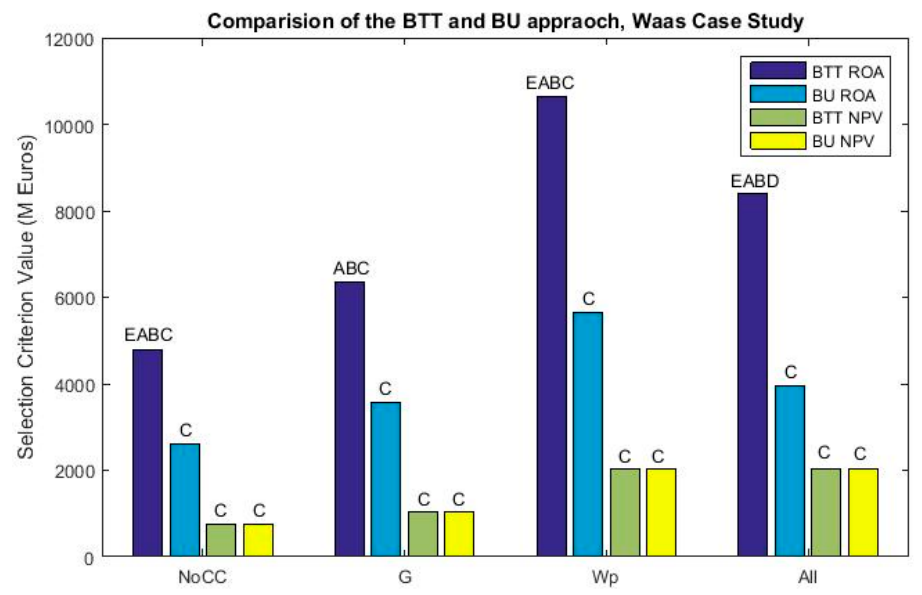
Figure 7. Pathways selected under different climate scenarios, by means of the BTT and BU approach using the Real Options Value and Net Present Value as selection criterions for the Waas Case Study.